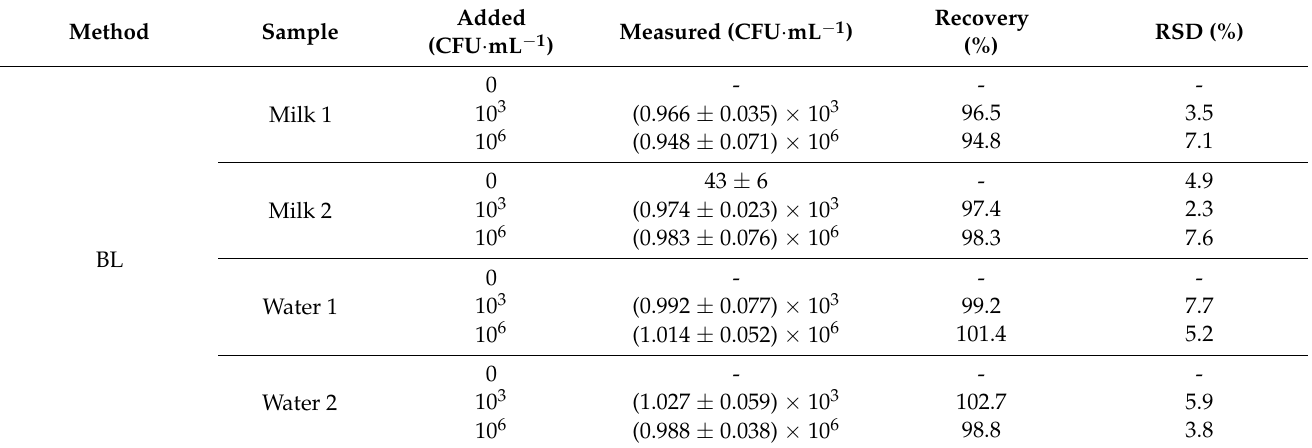
Table 3. Detection of live S.T in real samples by BL ( n